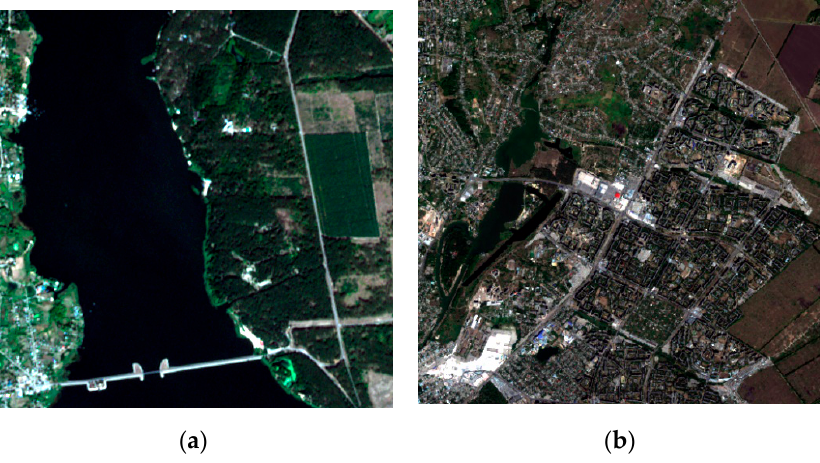
Figure 11. Fragments of Sentinel-2 images of Staryi Saltiv ( a ) and north part of Kharkiv ( b ).